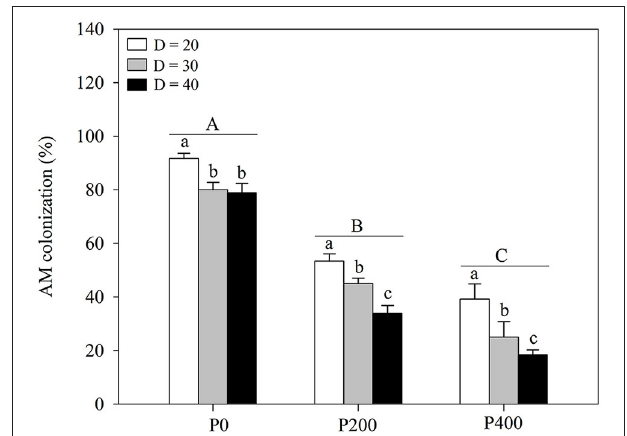
FIGURE 4 | Arbuscular mycorrhizal (AM) colonization under different phosphorous (P) supply gradients and space availability conditions. Each value represents the mean of four replicates ( + SD). Different lower-case letters indicate a significant difference among different space availability levels, and different capital letters indicate a significant among different P levels ( P < 0.05). P0, 0mg P kg − 1 soil; P200, 200mg P kg − 1 soil; and P400, 400mg P kg − 1 soil; D = 20, D = 30, and D = 40 represent diameter of pot is 20, 30, and 40cm,